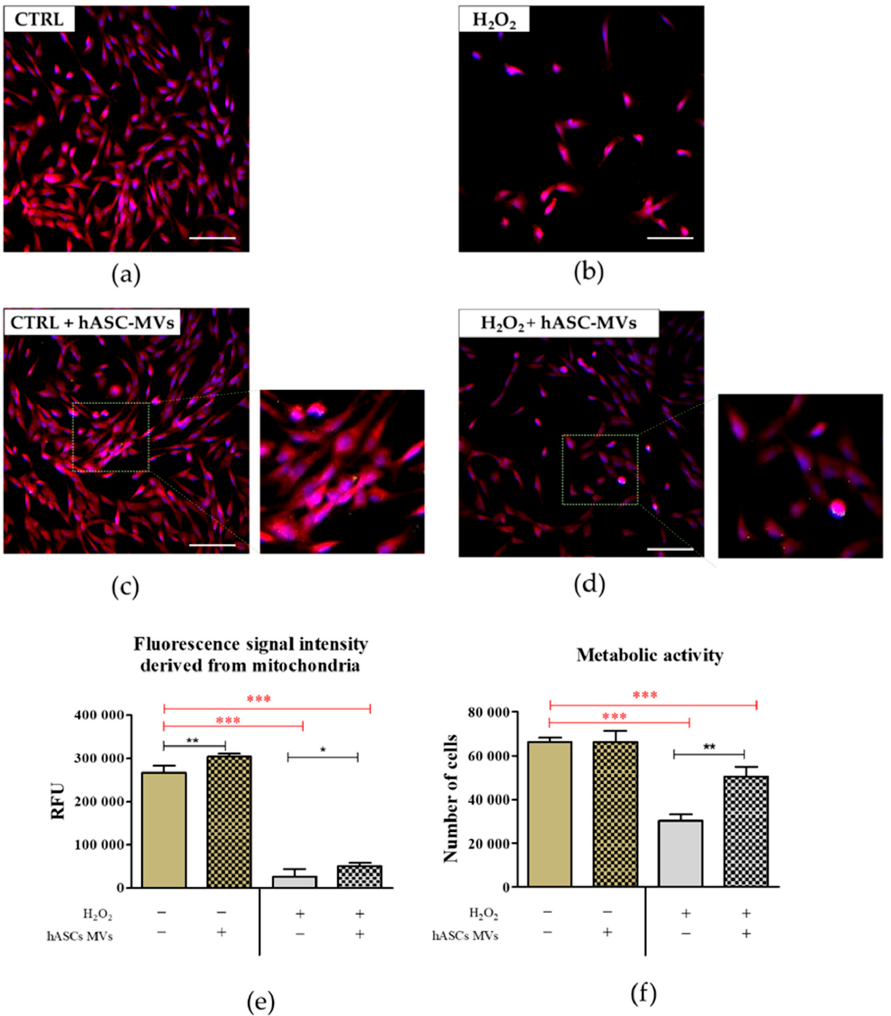
Figure 5. The analysis of mitochondrial morphology and activity, based on fluorescence signal intensity and analysis of CaMLCs metabolic activity. The control cultures were propagated using typical growth medium ( a ) as well as under oxidative stress conditions ( b ). The morphology of cells and mitochondria activity was determined also in cultures with introduced hASC-MVs ( c and d , respectively). The hASC-MVs were labeled with green PKH67 dye, notice in cultures as green-yellow dots (magnified square fields). Images were analyzed under 60-fold magnification (scale bar 200 μ m). The insensitivity of fluorescence derived from stained mitochondria was measured using ImageJ software ( e ). Metabolic activity was measured using Alamar Blue assay ( f ). The obtained results were used for statistical analysis. The significant di ff erences were marked using an asterisk (* p ≤ 0.05; ** p ≤ 0.01 and *** p ≤ 0.001). Di ff erences between healthy cultures and cultures with induced oxidative stress are additionally marked with red font. The results are expressed as mean ±